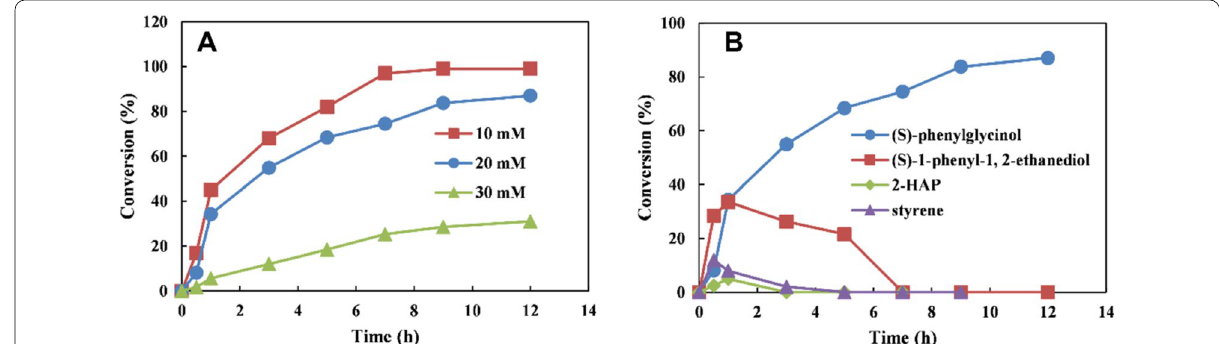
Fig. 5 Time course of the cascade reaction for the synthesis of ( S )-7 from L-PA 1. A Time course of the cascade reaction for conversion of 10–30 mM L-PA 1 to ( S )- 7 ; B time course of the cascade reaction for intermediate produced from L-PA 1 . Reaction conditions (5 mL): 100 mM phosphate buffer (pH 7.5), 10–30 mM L-PA, 10 mM glucose, 20 g cdw/L E. coli (RFP-DEA-CGS), 15 g cdw/L E. coli (MVTA), 30 mM ( R )-MBA and 0.1 mM PLP, at 25 °C. All biotransformations were performed in duplicate and conversion was determined by GC, error limit: < 2% of the state